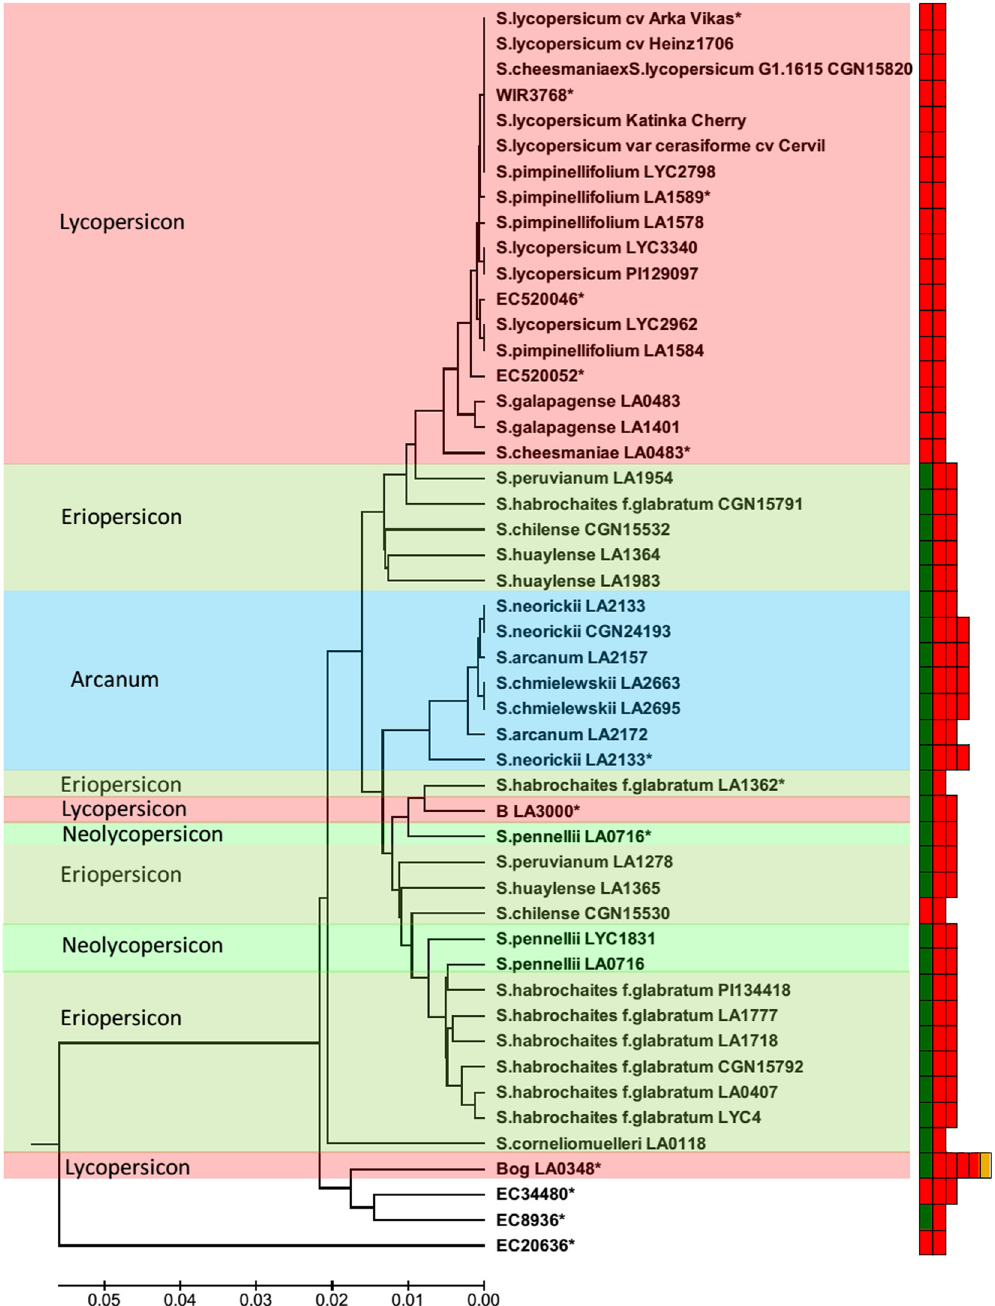
Fig 3. Evolutionary relationships of CYC-B promoter sequences from 49 tomato accessions. All sequences corresponding to – 1 to – 876 bp region of the reference variety ( S . lycopersicum cv. Arka Vikas) was used for constructing the tree using MEGA6. The optimal tree with the sum of branch length = 0.38 is shown. The number of RIN binding sites in the CYC-B promoter sequence of the accessions are indicated with coloured boxes (right): CARGATCONSENSUS (green), CARGCW8GAT (red) and CARGNCAT (yellow).